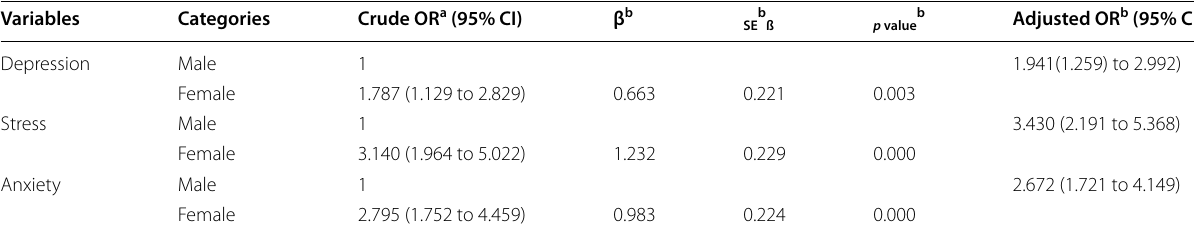
Table 4 Association between gender and anxiety, depression, and stress among the participants